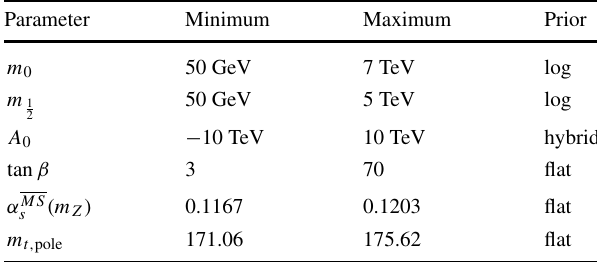
Table 9 CMSSM parameters varied in the example fit, along with their associated ranges and prior types. The “hybrid” prior on A 0 is logarith- mic for | A 0 | > 100 GeV and flat for | A 0 | < 100